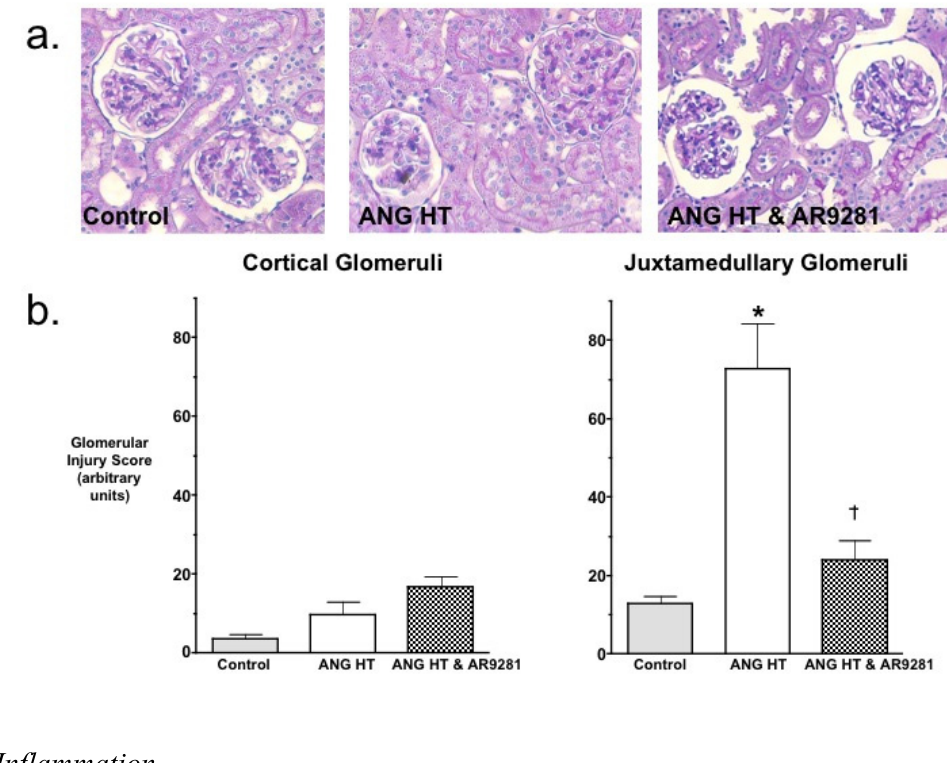
Figure 2. The effect of the sEHI, AR9281 on glomerular injury in angiotensin-infused rats (ANG HT). (a) Representative pictures of glomerular histological analysis. (b) Glomerular injury scores in cortical glomeruli (left graph) and juxtamedullary glomeruli (right graph). Values are mean ± SEM. *Significant difference between control and ANG HT & vehicle groups, = significant difference between ANG HT & vehicle and ANG HT & AR9281